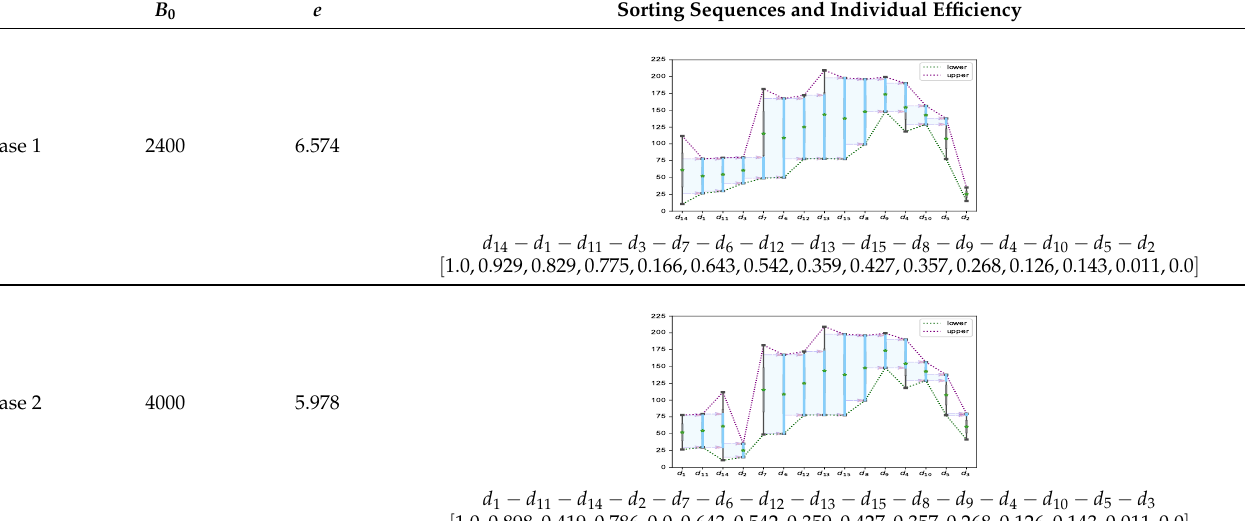
Table A5. Solutions of sorted negotiation Model (19) ( p = 0.95 ) . Sorting Sequences and Individual